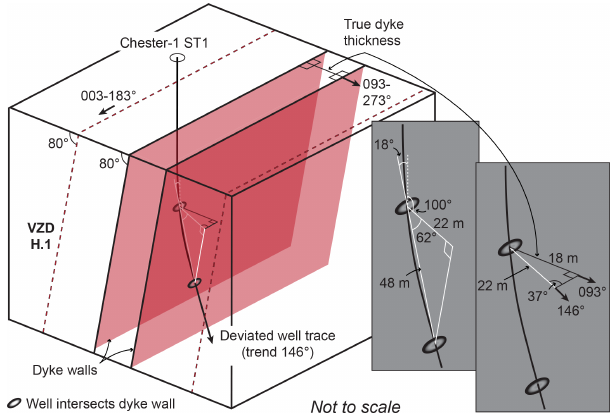
Figure 14. Schematic showing how the deviation inclination and direction of the Chester-1 ST1 borehole can be used to estimate true dyke thickness assuming the dyke walls are parallel to the VZD H.1 boundaries. By taking the intersected thickness (48m) of the dyke and the inclination of the SE-dipping deviated well trace (18 ◦ from vertical), relative to the W-dipping (80 ◦ ) VZD, we can use trigonometry to determine that the distance between the dyke wall and well intersections, on a plane orthogonal to the dyke walls (i.e. 100 ◦ from vertical), is 22m. This information, coupled with the difference between the VZD strike (093–273 ◦ and well azimuth (146 ◦ ), allows us to determine the true dyke thickness is ∼